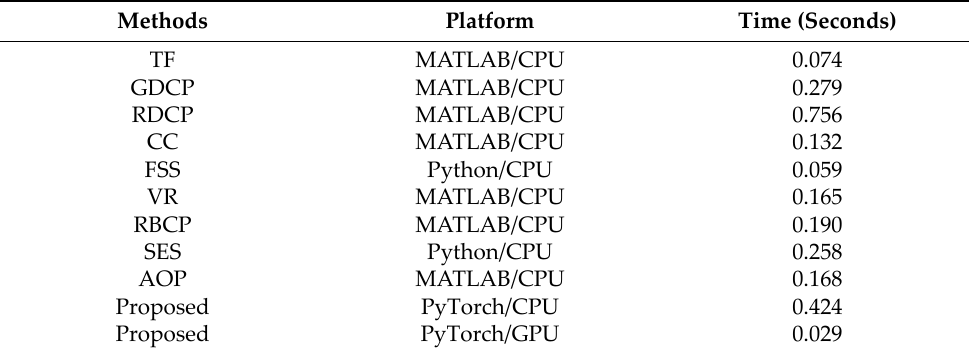
Table 5. Comparison of the average running time of different algorithms.